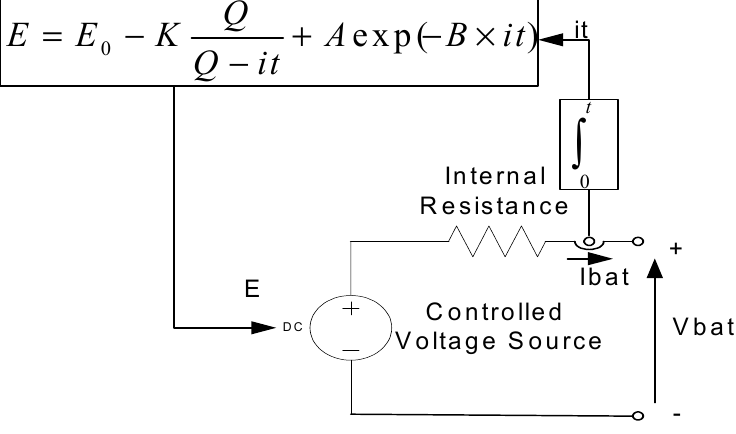
Figure 3. The Battery Model used in the